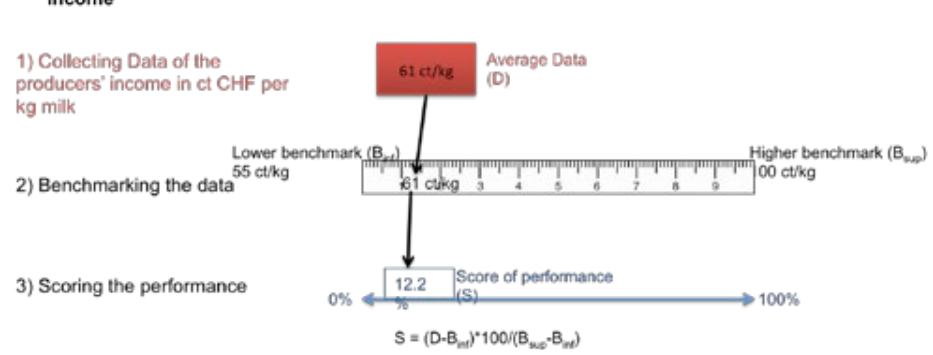
Figure 1. Benchmarking system of indicators with the example of the indicator “Producers’